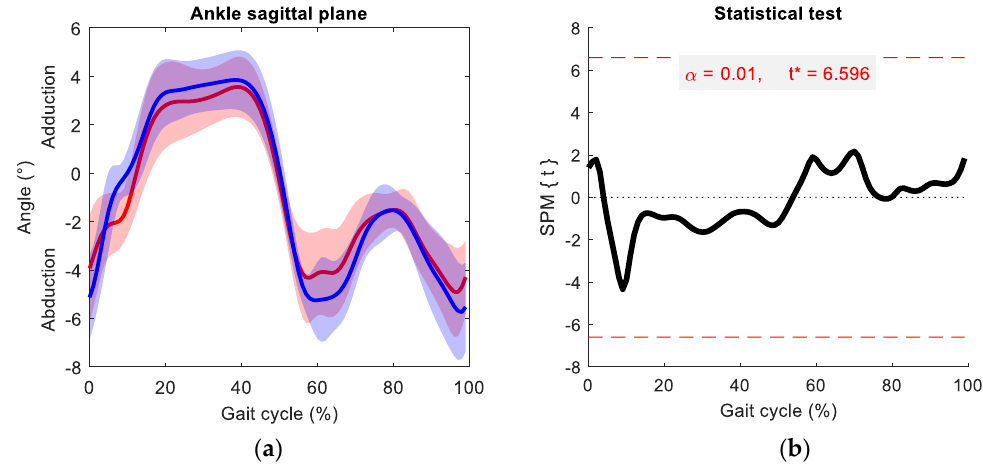
Figure 6. ( a ) Mean transverse ankle angle during gait cycle from heel strike to heel strike with (red) and without (blue) exosuit, and ( b ) statistical 1D SPM test; * critical t-value. The mean trajectory of the ankle frontal plane is shown in Figure 7. Positive values indicate the inversion movement, whereas negative values present eversion movement. The maximal difference between the two conditions was 3.43 ± 1.62° at 64% of gait cycle (initial swing phase). Additionally, walking with the exosuit had a slightly larger variance.